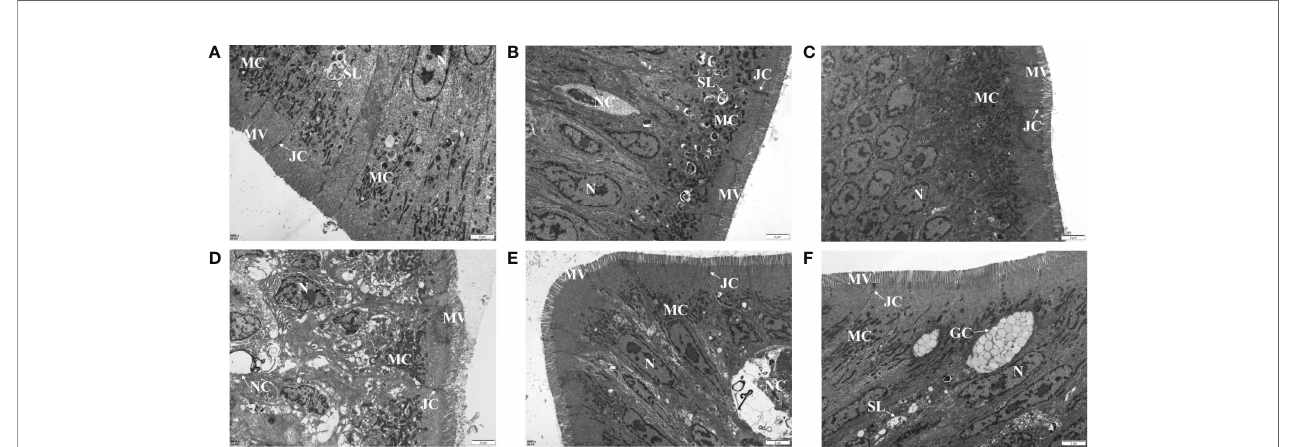
FIGURE 5 | Effects of MOS supplementation on the intestinal ultrastructure of M. amblycephala by TEM assay. (A – C) Mid-intestine sections of control, MOS200, and MOS400 groups at 0 hpi, respectively. (D – F) Sections at 24 hpi. G, goblet cell. Scale bars represented 2 µm (8,000×).